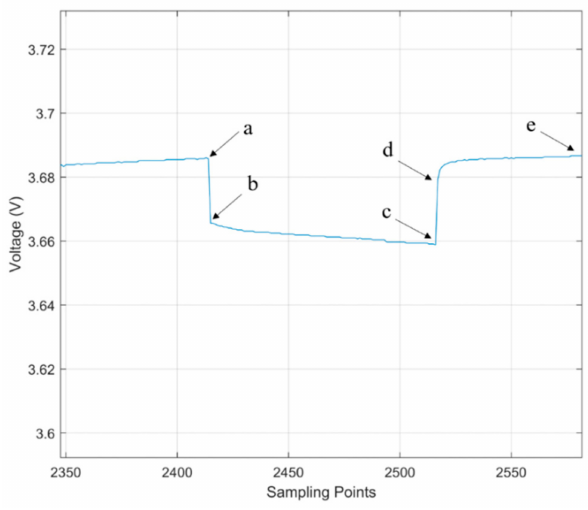
Figure 3. Voltage response curve under HPPC